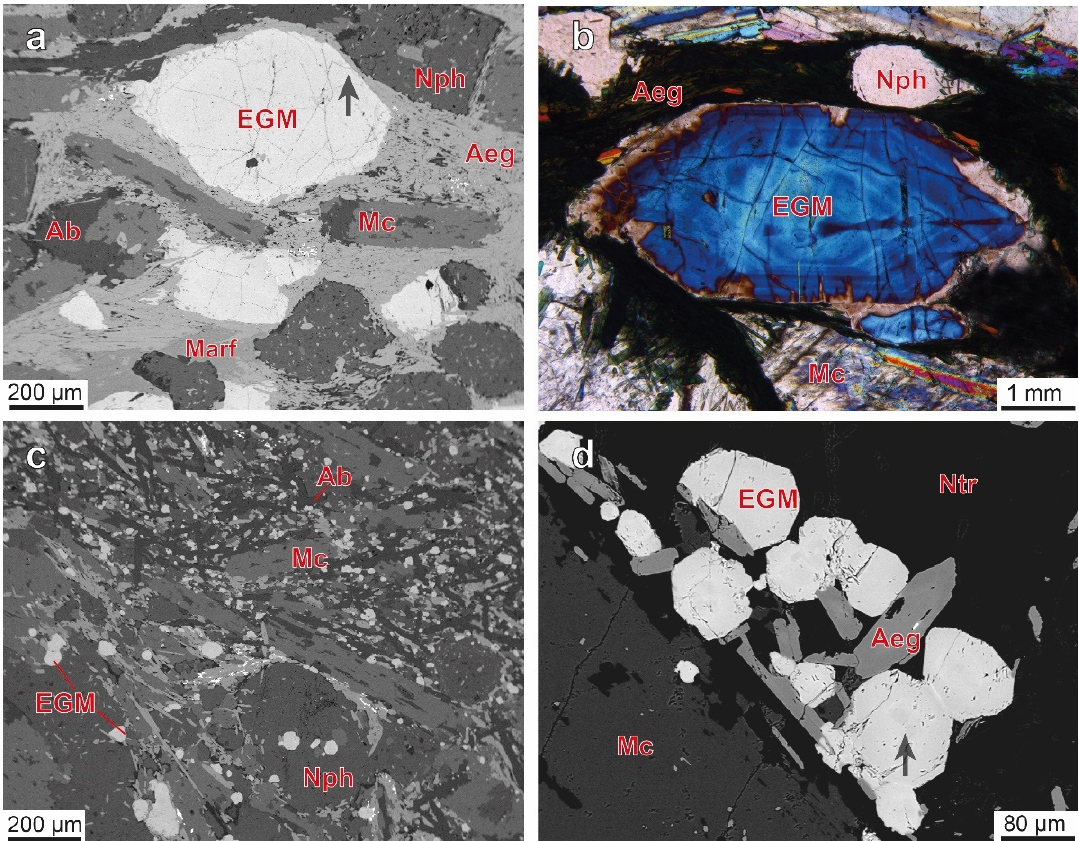
Figure 2. ( a ) Backscattered electron (BSE) image of eudialyte lujavrite rock (Sample LV-153/178). Black arrow indicates point were selected crystal part for SC XRD analysis; ( b ) optically zonal EGM grain from LV-153/178 sample under crossed polars; ( c ) BSE image of porphyritic nepheline syenite (LV-117/226 sample); ( d ) Zr-enriched EGM from porphyritic nepheline syenite (LV-117/226 sample). Associated minerals are albite (Ab), aegirine (Aeg), magnesio-arfvedsonite (Marf), microcline (Mc) nepheline (Nph) and natrolite (Ntr).